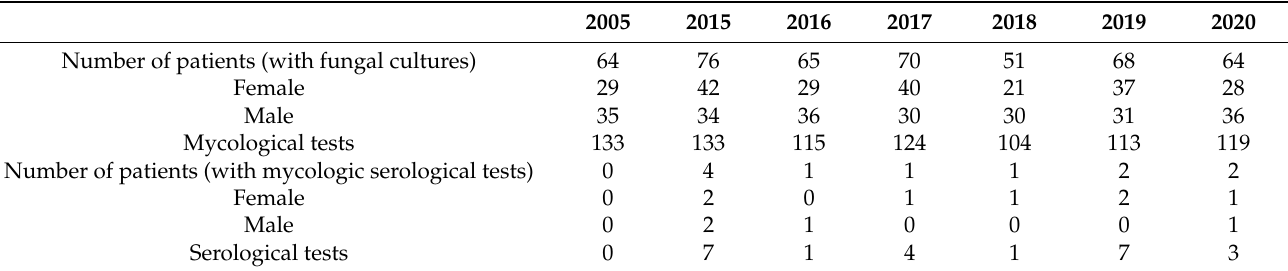
Table 2. Mycological tests in NICU